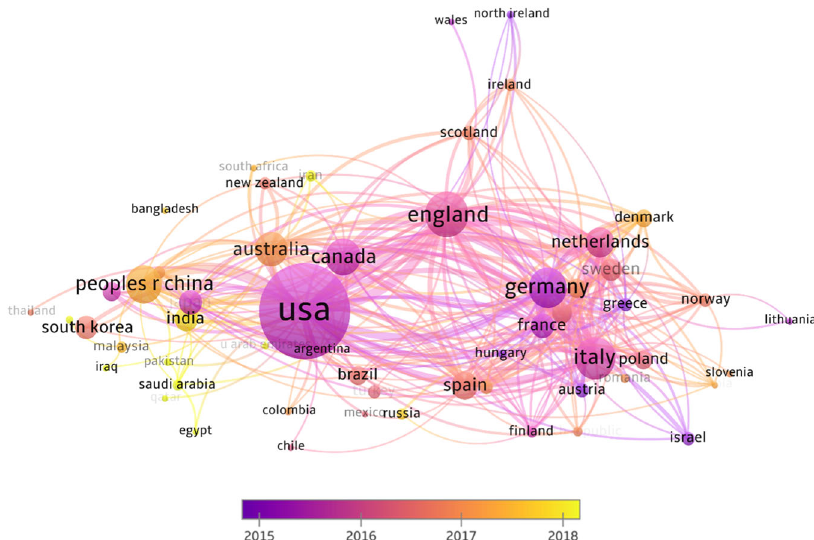
Fig. 2 Patterns of scholarly collaborations between countries. The strength of collaborations between researchers from different countries, de fi ned by number of documents, is indicated by the width of the